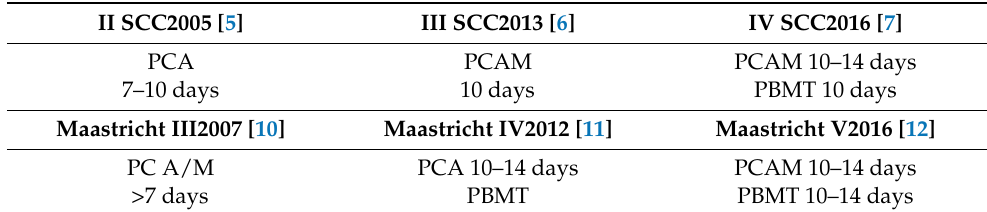
Table 1. First-line treatments recommended in Spanish Consensus Conferences (SCC) and Maas- tricht/Florence Reports during the last